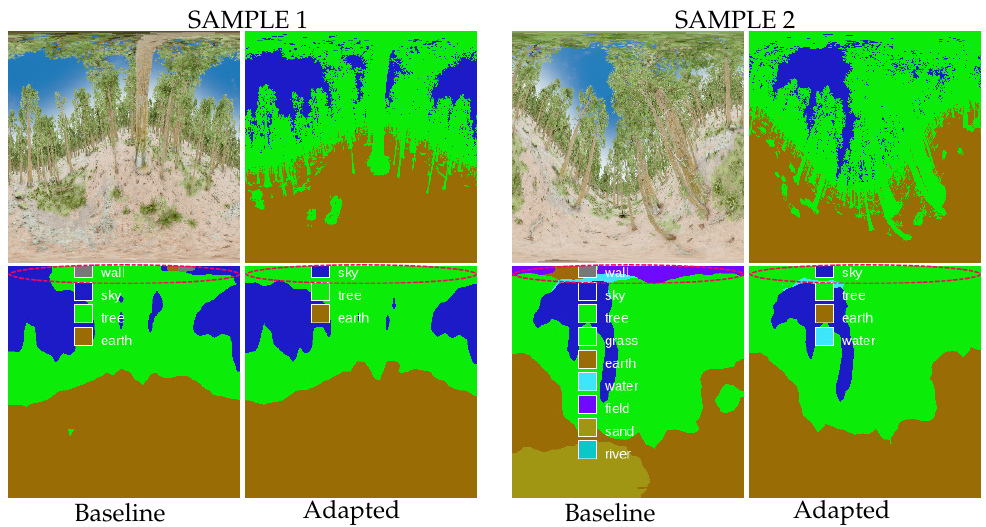
Figure 5. Prediction examples in the RWFOREST dataset. The spherical adaptation improves shape detection (tree canopy is better identified) and reduces erroneous class estimation. ( Top left ): RGB input, ( top right ): ground-truth segmentation, ( bottom left ): prediction from the baseline network, ( bottom right ): prediction from the adapted network.